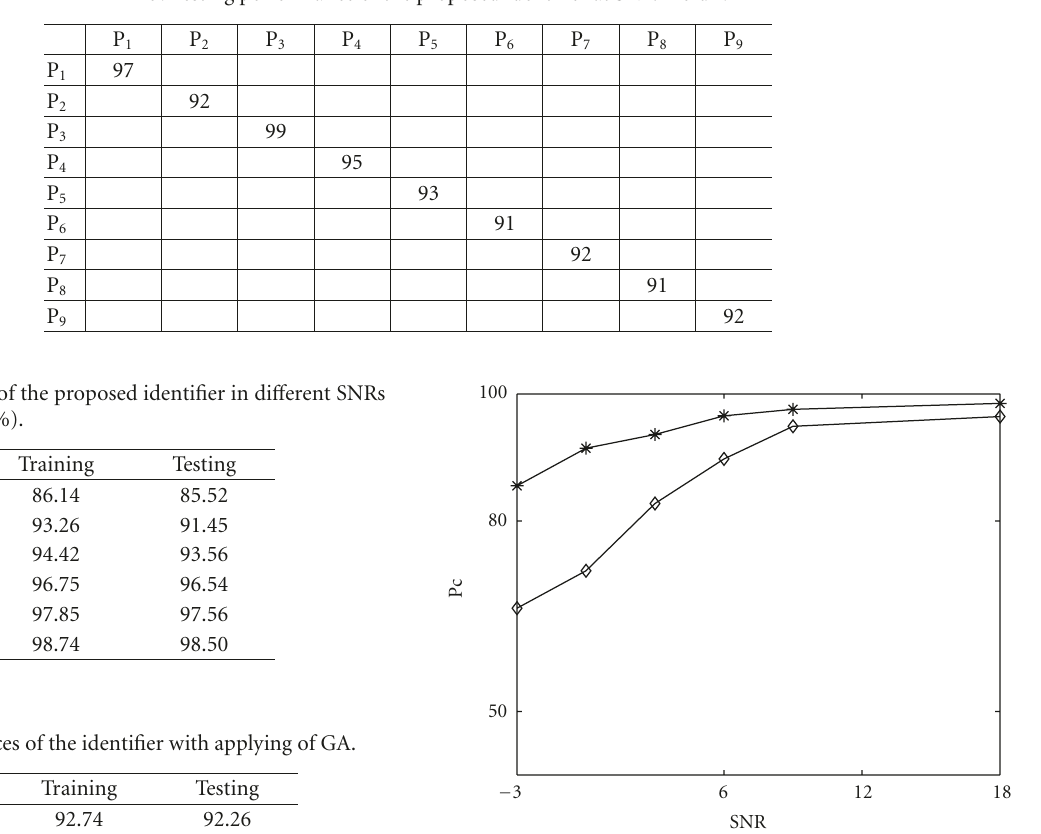
Table 3: Testing performance of the proposed identifier at SNR = 3 dB.